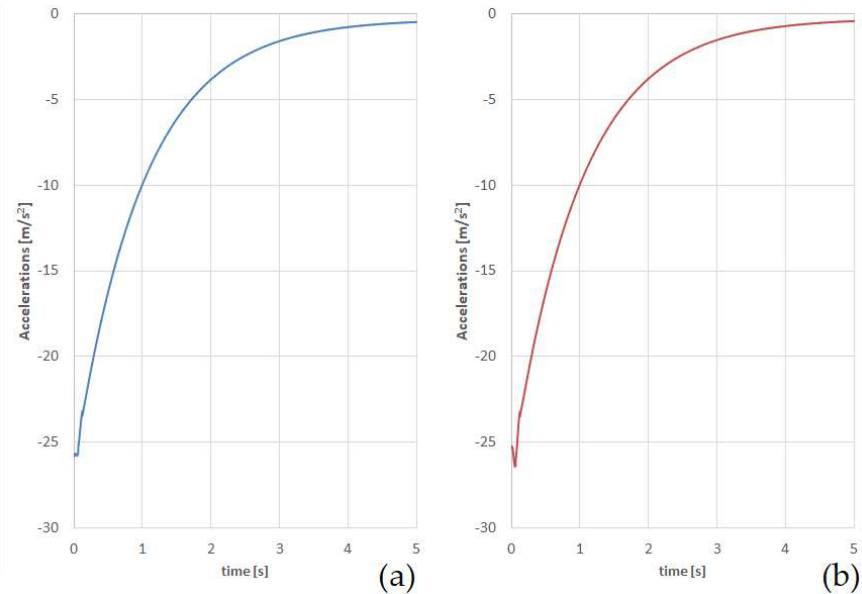
Figure 8. Accelerations on the carrying structure of the articulated boxcar: ( a ) first and ( b ) second sections of the flat wagon from longitudinal force. Appl. Sci. 2020 , 10 , x FOR PEER REVIEW